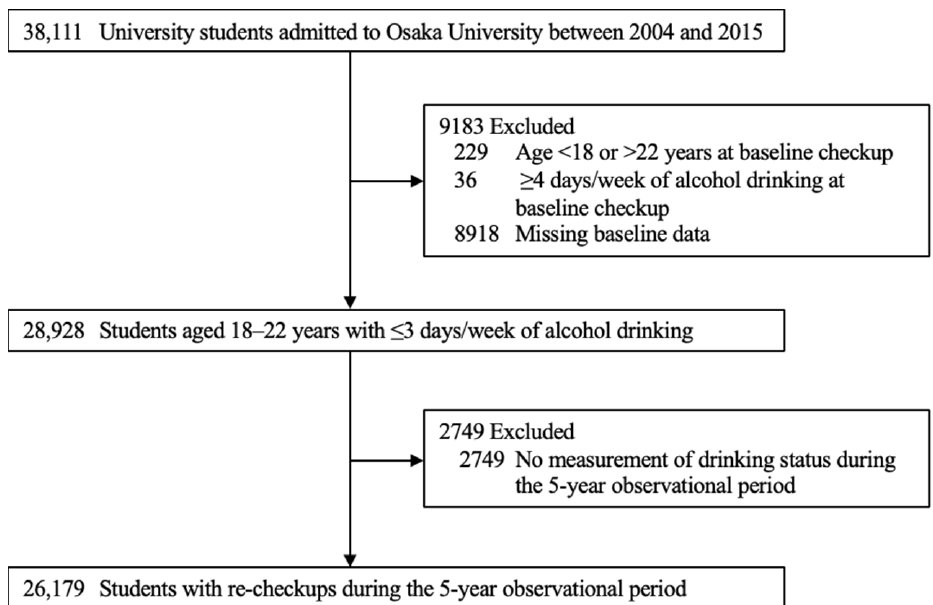
Figure 1. Flow diagram of inclusion and exclusion of study participants.